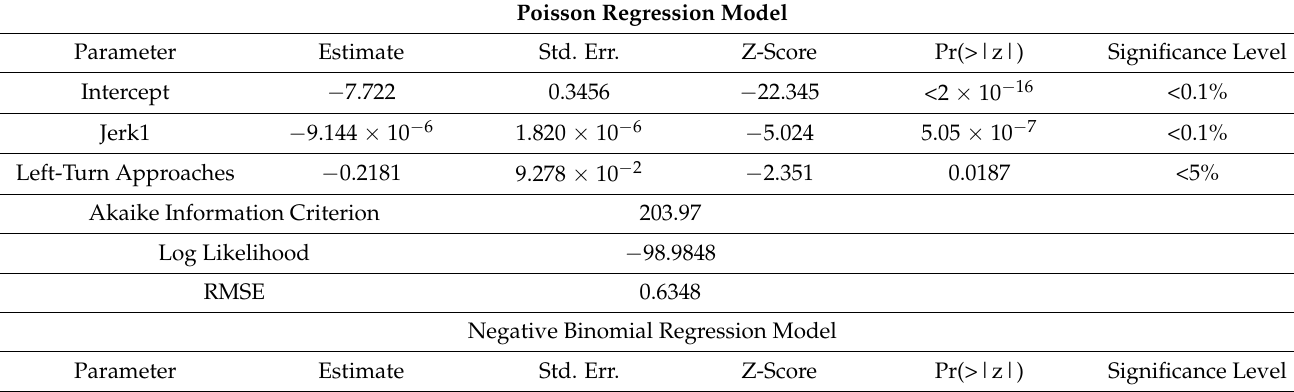
Table 5. Summary of regression models for intersection analysis with outliers removed. Poisson Regression Model